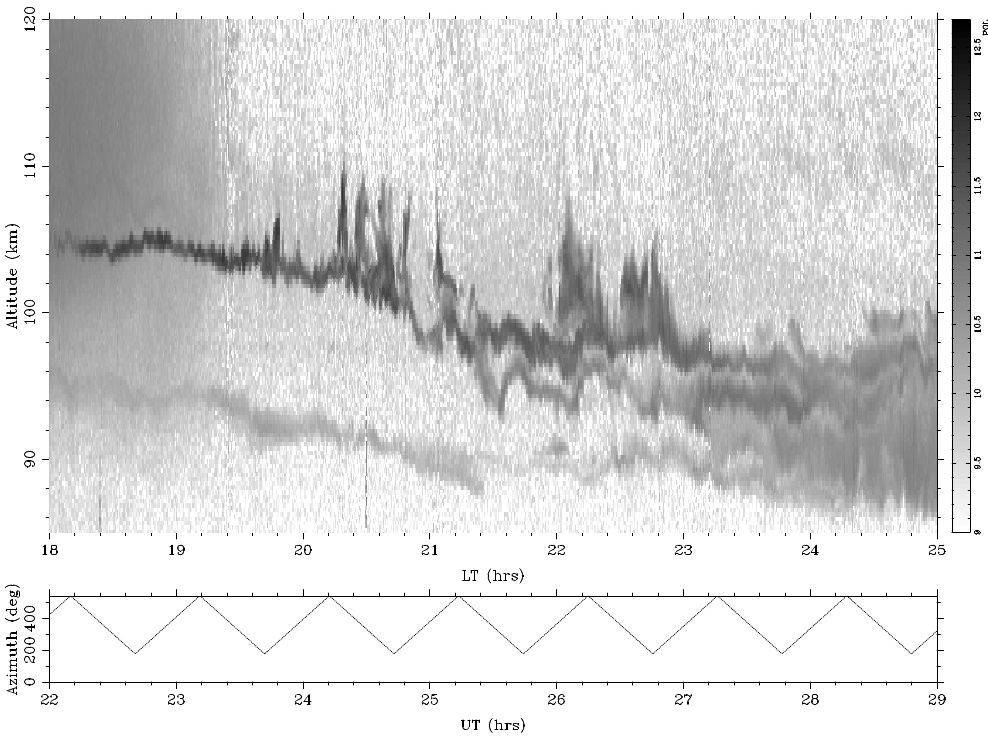
Fig. 4. Electron densities measured with the Arecibo linefeed antenna.